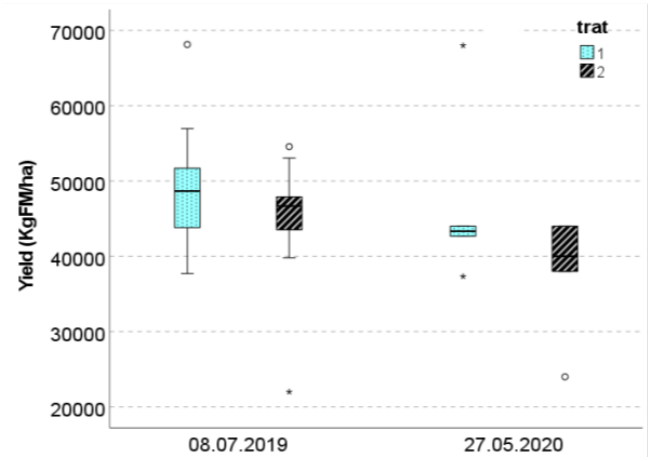
Figure 3. Box plot of fresh plant weight showing the effects of date (2019 and 2020, not significantly different) and treatment (T1 > T2 at p = 0.1 level).